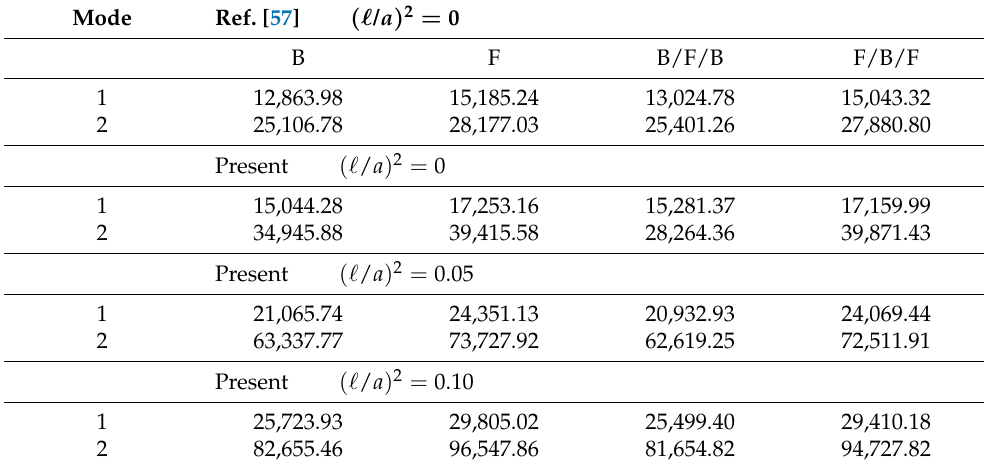
Table 4. Natural frequencies (rad/s) of a simply supported square plate ( a = 1 m; h = 0.3 m). B = BaTiO 3 ; F = CoFe 2 O 4